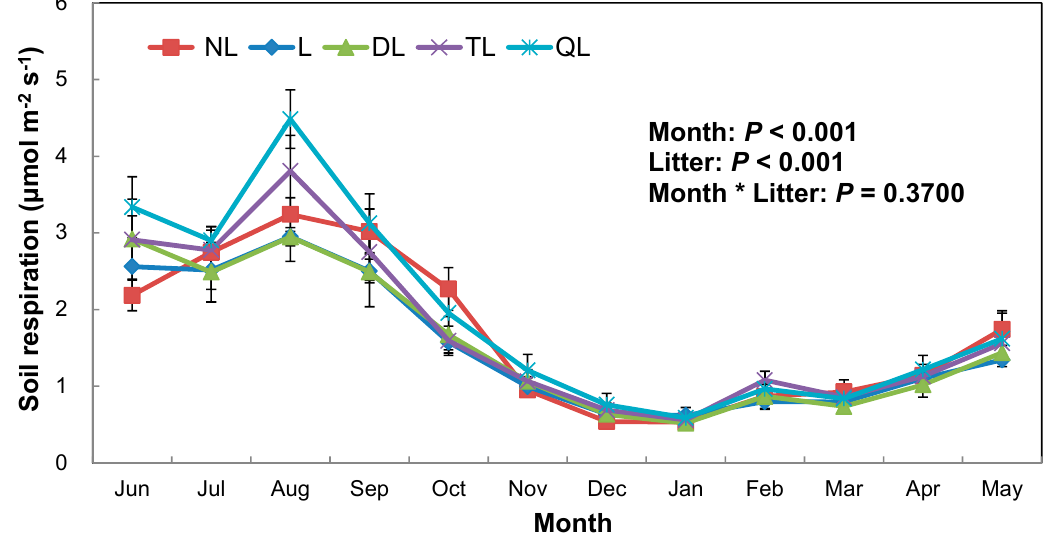
Figure 4. Effects of litter quantity on soil respiration. Values are presented as the means ± standard error. See Figure 1 for abbreviations. 219